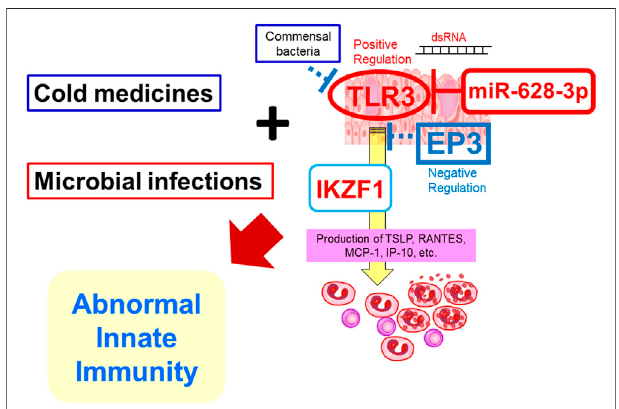
FIGURE 2 | Abnormal innate immunity may be involved in the development of SJS/TEN with